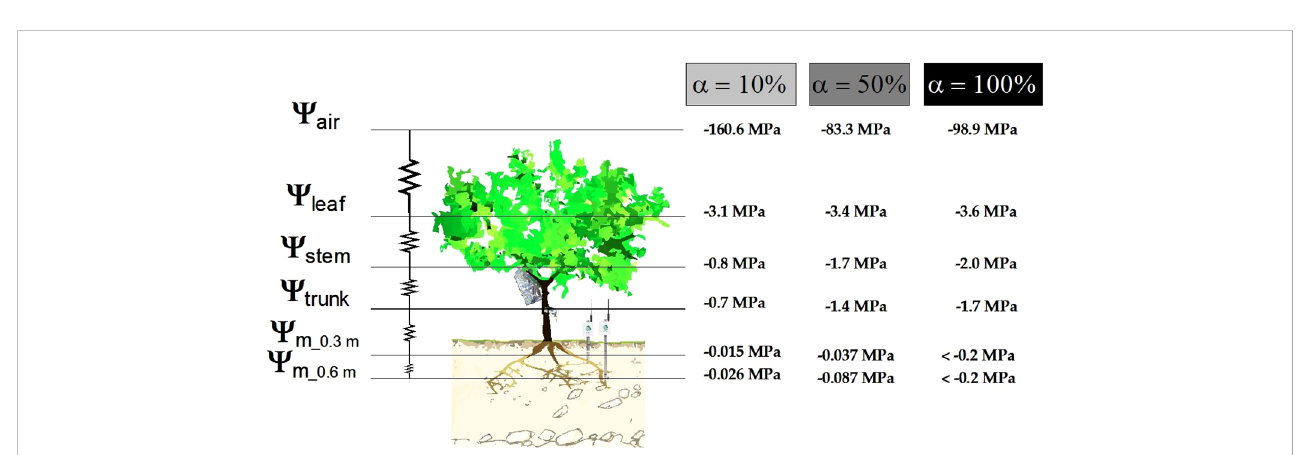
FIGURE 7 Mean values of water potential at midday in the SPAC during each irrigation criterion: a =10% (well-irrigated), a =50% (moderate water de fi cit), and a =100% (severe water de fi cit, non-irrigated).